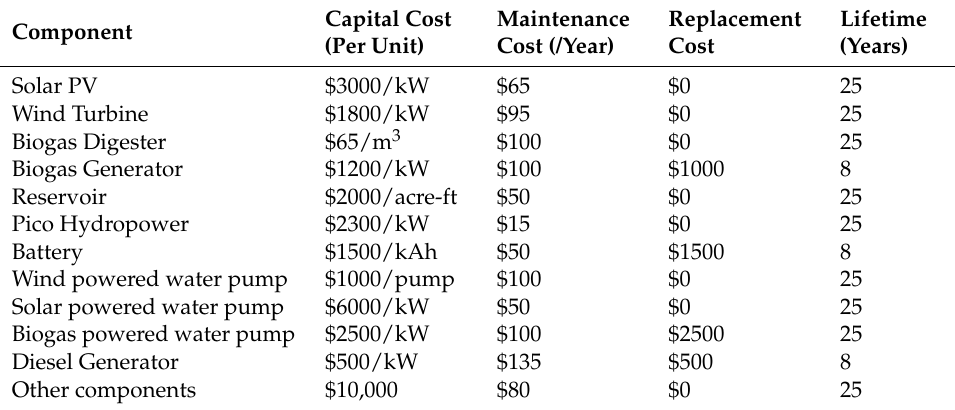
Table 4. Capital cost, Maintenance cost and Replacement cost for System Components.